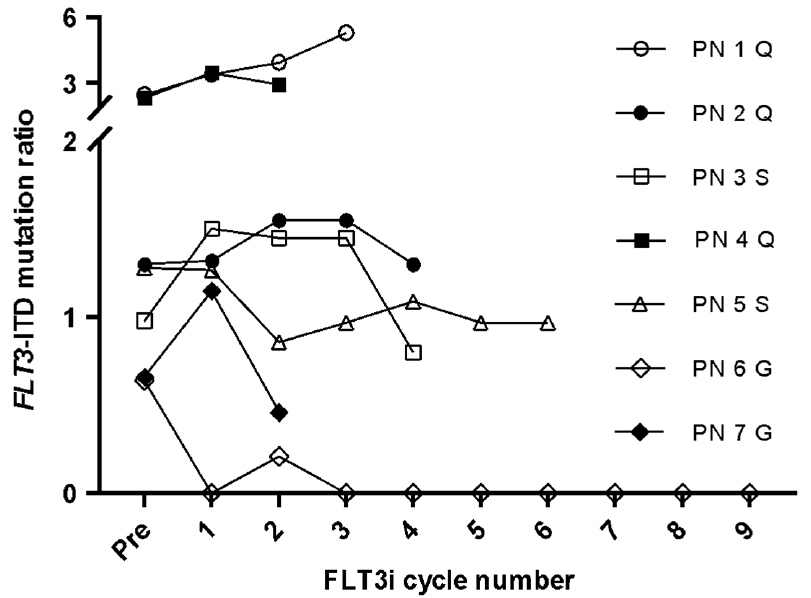
Figure 5. FLT3 -ITD mutation ratio during follow-up of the seven patients treated with FLT3 tyrosine kinase inhibitors. PN: patient number. FLT3i: tyrosine kinase inhibitors. Q: quizartinib. S: sorafenib. G: gilteritinib.